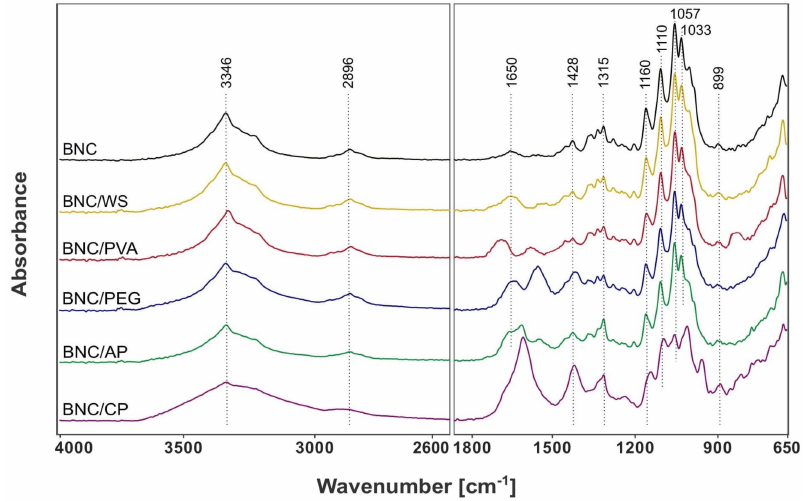
Figure 13. Comparison of ATR-FTIR spectra of native and modified BNC